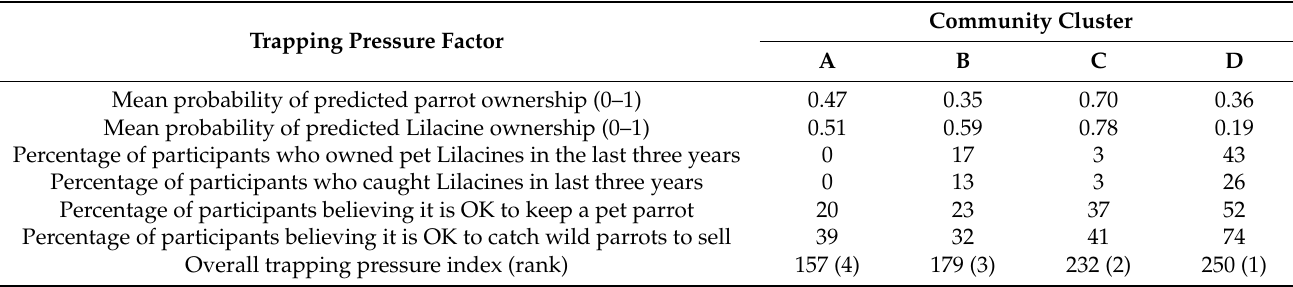
Table 6. Trapping pressure index for each community cluster, calculated by adding together factors of predicted or reported level of pet ownership and trapping, and attitudes towards pet keeping, capture and trade. Predicted probabilities were converted into percentages for this